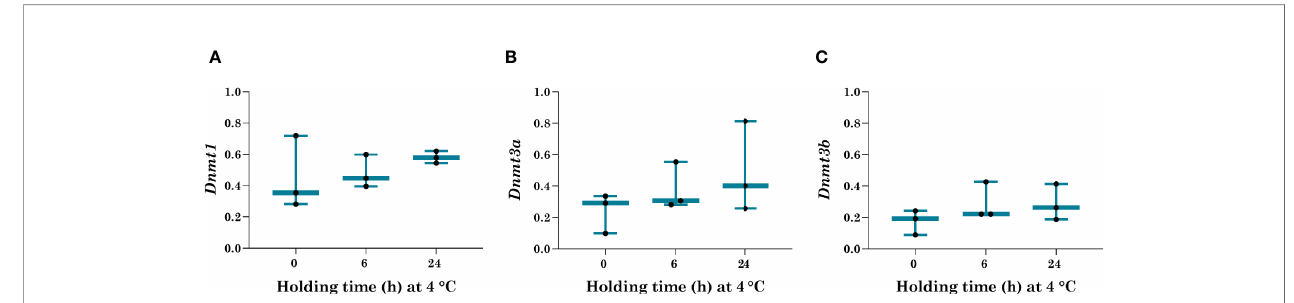
FIGURE 2 | mRNA expression of Dnmt1 , Dnmt3a , and Dnmt3b . Real-time q PCR analysis to understand the effect of varying holding duration at 4°C on mRNA levels of (A) Dnmt1 , (B) Dnmt3a , and (C) Dnmt3b . ITT held for 0 h at 4°C cultured for 14 days was used as a control in comparison to 6 and 24 h held cultured ITT in similar conditions. mRNA level of Dnmt1 , Dnmt3a , and Dnmt3b gene was normalized against reference genes Actb and Gapdh. Data are presented as Mean ± SEM (n =